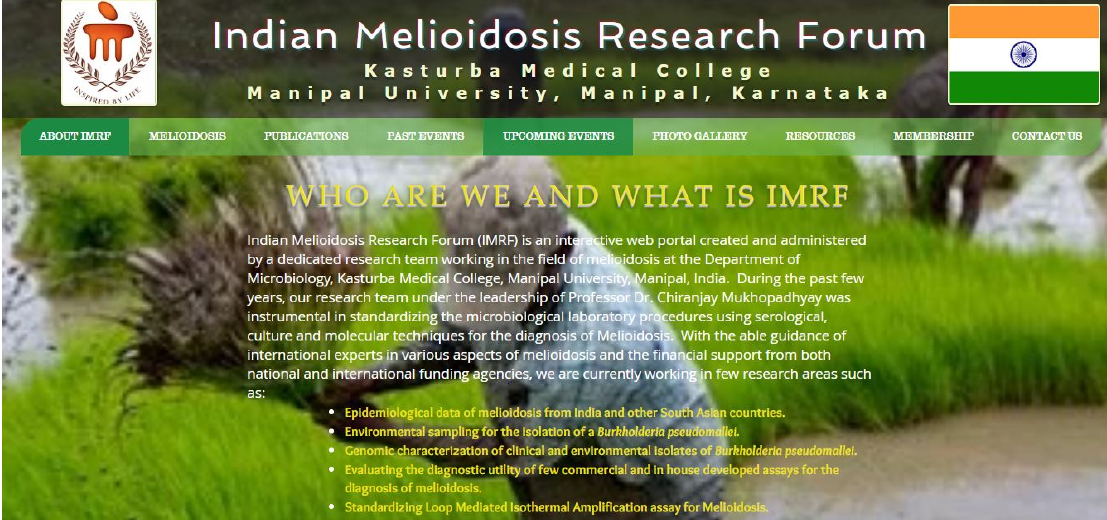
Figure 5. The Indian Melioidosis Research Forum (IMRF) has effectively brought researchers from all over India for research in melioidosis for the last two years. Table 2. Isolates received by the Manipal Center for Emerging and Tropical Diseases for confirmation from various centers in India.